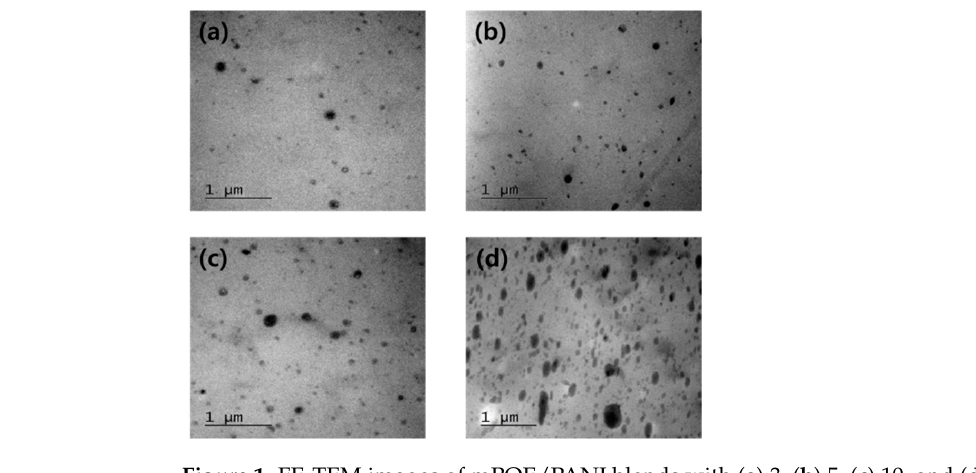
Figure 1. FE-TEM images of mPOE/PANI blends with ( a ) 3, ( b ) 5, ( c ) 10, and ( d ) 15 wt.% of PANI content (magnification ×50.0k).